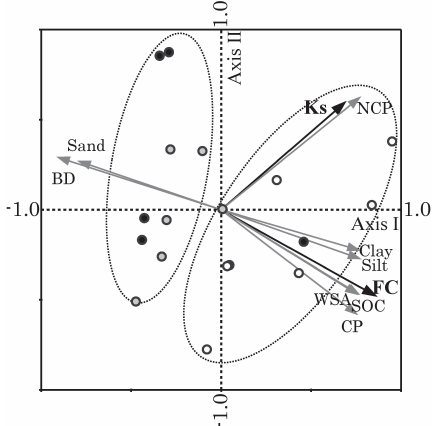
Figure 7. Redundancy analysis of soil hydraulic properties and ba- sic properties under different degradation stages. Symbols “ (cid:13) ”, gray and black “ • ” denote soil samples from lightly degraded (LD), moderately degraded (MD) and severely degraded (SD), respec- tively. The two axes represent the principal component (PC) ex- tracted from the explanatory variables (basic soil properties). The first ordination axis (axis I, horizontal) mainly reflected the in- fluence of bulk density (BD), soil organic carbon (SOC) and soil texture, and the second axis (axis II, vertical) mainly reflected the influence of capillary porosity (CP) and non-capillary poros- ity (NCP). FC: field capacity, K s : saturated hydraulic conductivity, WSAs: water-stable aggregates.